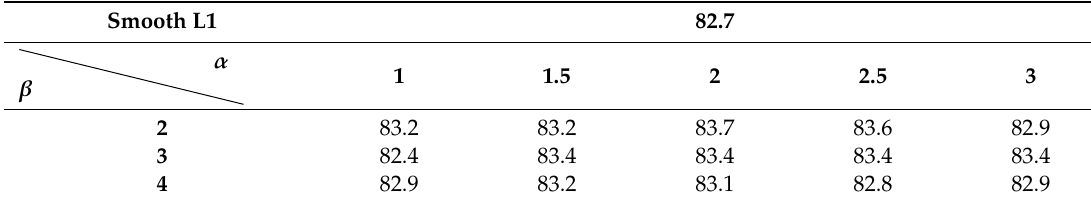
Table 6. Ablation studies of the smoother L1 on the validation